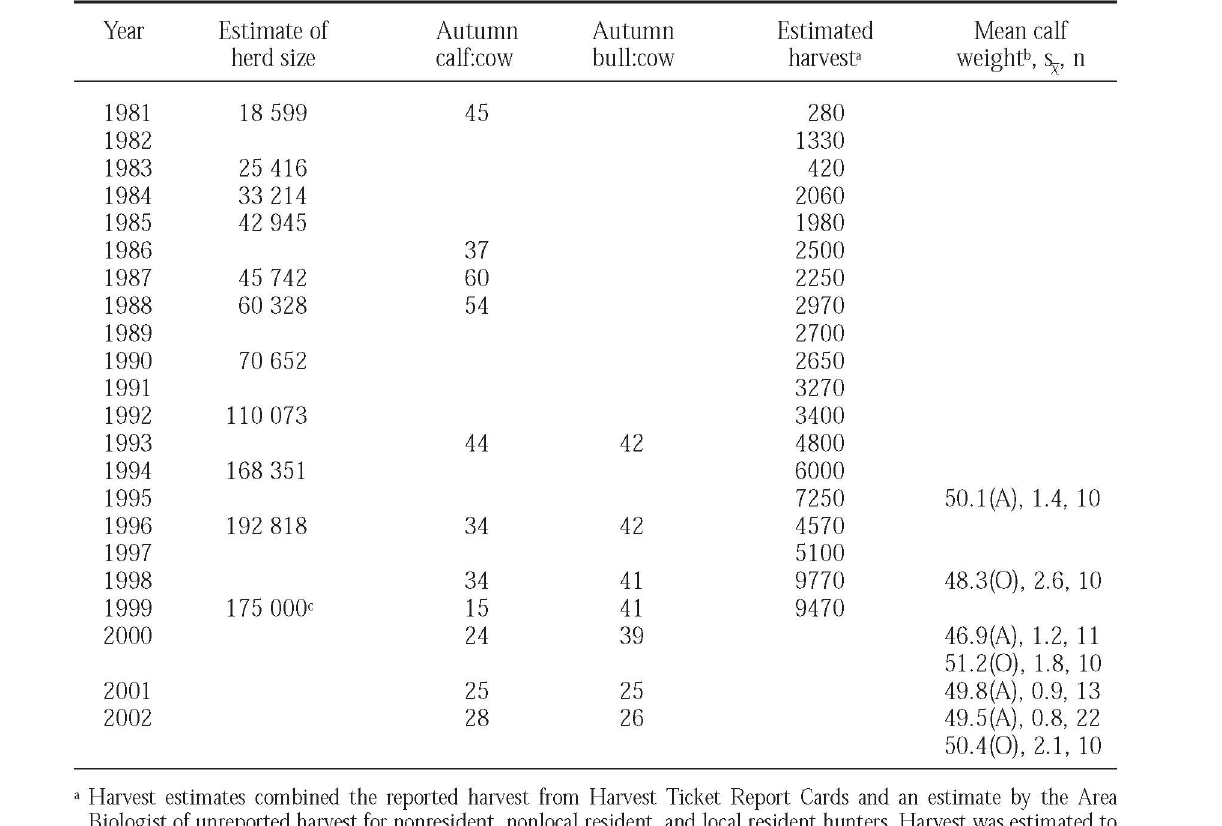
Table 1. Estimates of herd size, fall calf:cow ratio, and calf weight in the Mulchatna Caribou Herd, 1981-2002. Year Estimate of Autumn Autumn Estimated Mean calf herd size calf:cow bull:cow harvest